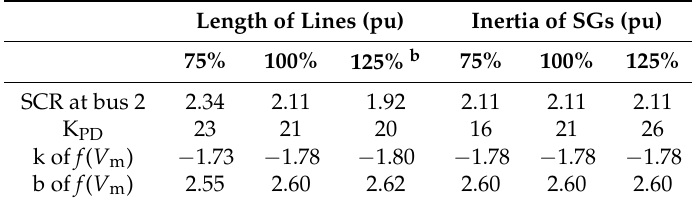
Table 5. System information under different grid strengths.